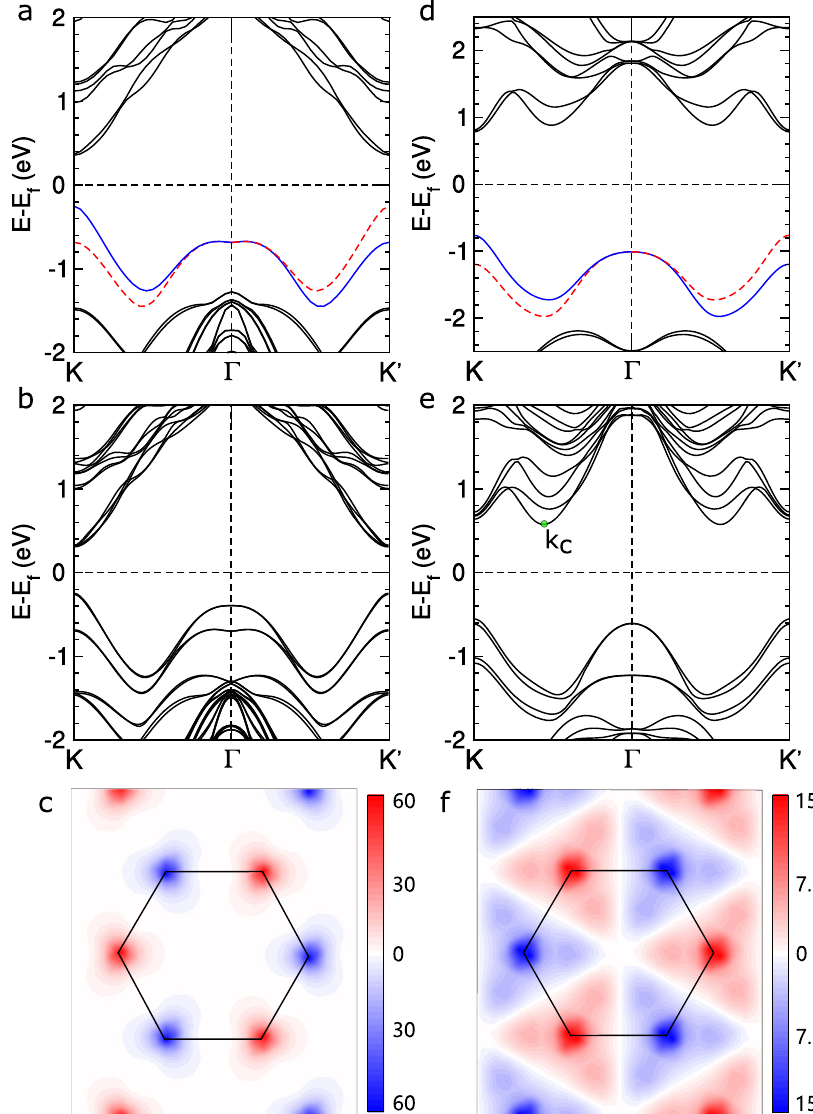
Fig. 6 Comparison of electron valleys in between α 2 -WSi 2 P 4 and 2 H -WSe 2 . a , d Band structure for α 2 -WSi 2 P 4 and 2 H -WSe 2 monolayers. The blue and red lines represent different spin states. b , e Band structure for the bilayer of α 2 -WSi 2 P 4 and 2 H -WSe 2 . k c in e indicates the CBM. d , f Berry curvature of α 2 - WSi 2 P 4 and 2 H -WSe 2 monolayers near the K and K 0 valleys. The black hexagons show the fi rst Brillouin zones of the